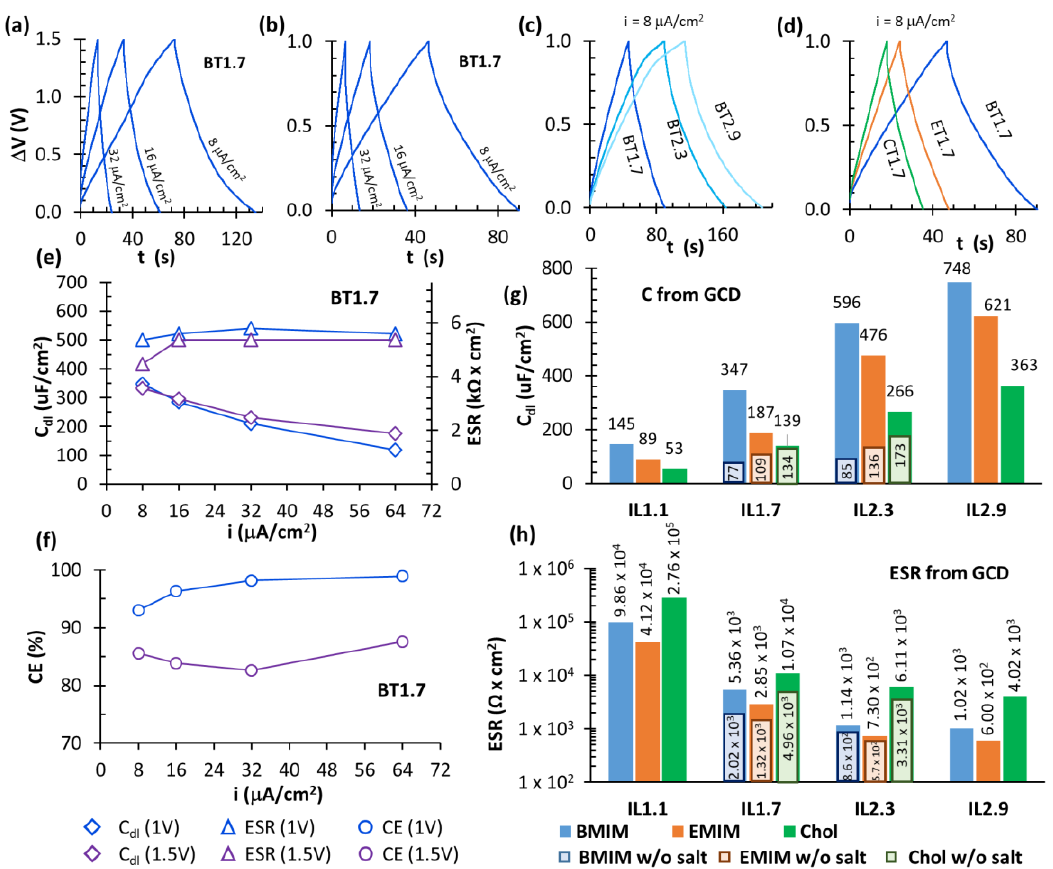
Figure 6. Galvanostatic charge and discharge (GCD) curves of: ( a , b ) BT1.7 at i A = 8, 16, 32 µ A / cm 2 and ∆ V = 1.5 V and 1 V, respectively; ( c ) BT at di ff erent concentration at i max ( d ) di ff erent ILs at the same concentration (1.7), i A = 8 µ A / cm 2 and ∆ V max = 1V. ( e , f ) C dl , ESR and coulombic e ffi ciency (CE) calculated for BT1.7 at di ff erent applied currents; ( g , h ) Capacitance and ESR (respectively) of all supercapacitors, calculated from GCD characterization ( ∆ V max = 1.0 V and i A = 8 µ A / cm 2